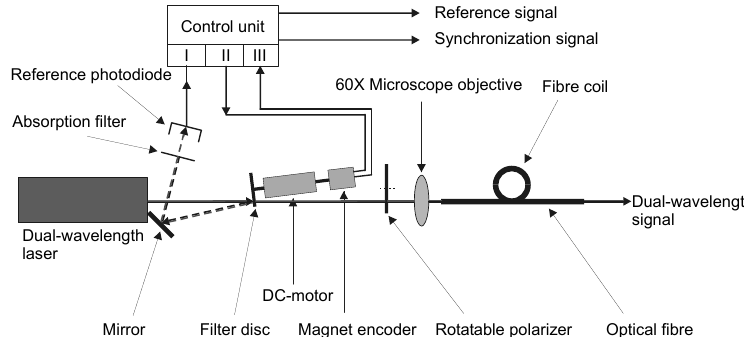
Fig. 7. Optical scheme of the two wavelengths-emitting unit (Böckem 2001)